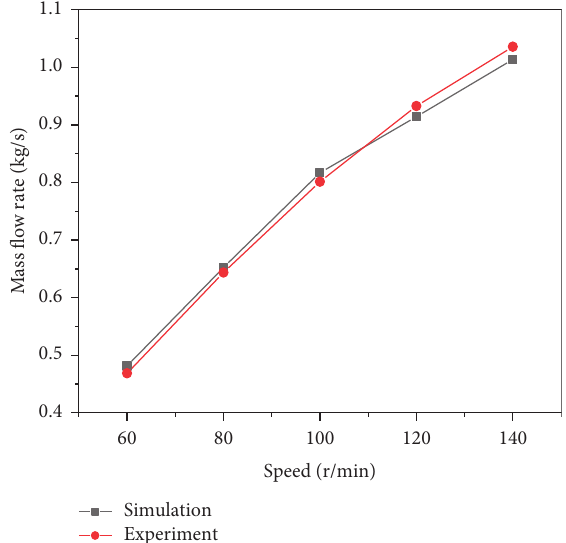
Figure 7: Comparative analysis of simulation and experiment of screw conveying at different